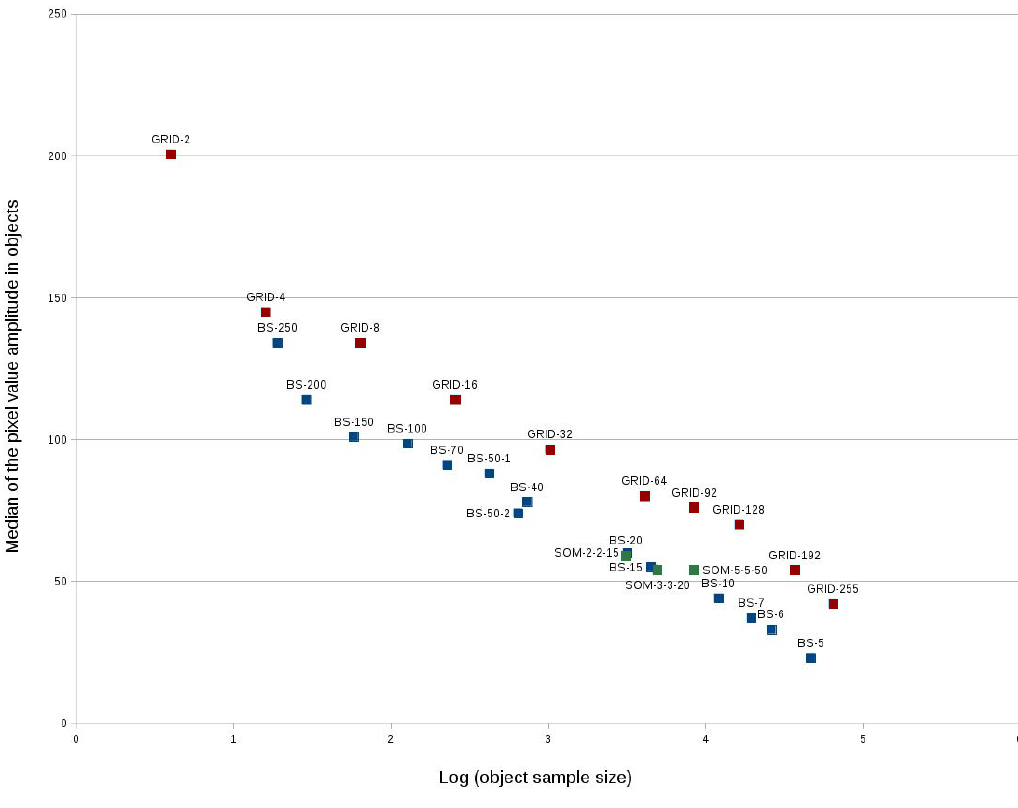
Figure 14. Median of the pixel value amplitude in